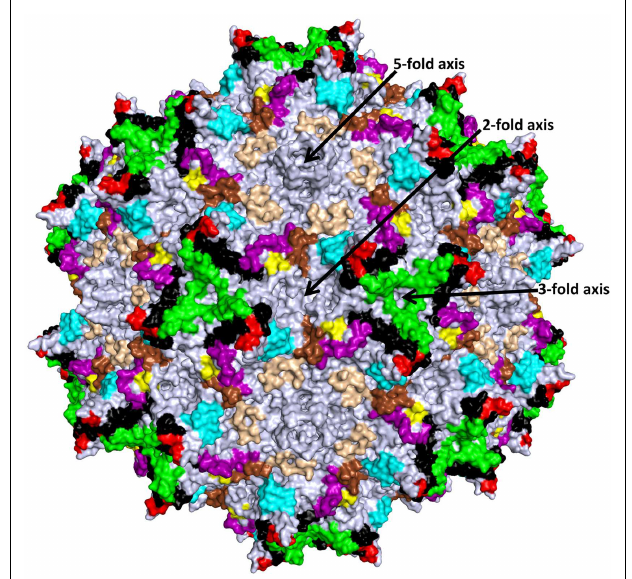
FIGURE 3 | Structurally mappedAAV antigenic epitopes .The epitopes identified on the AAV capsid surface by cryo-reconstruction structure are depicted in the colors used for theVRs in Figure 2 based on overlap with theVR amino acids; aa253–271: purple; aa383–386: yellow; aa456–459: red; aa492–515: black; aa544–557: cyan; aa582–597: green; aa659–669: wheat; and aa709–720: brown. Amino acids 659–669 (wheat) were not previously described asVR regions.The approximate icosahedral 2-, 3-, and 5-fold symmetry axes are indicated and labeled as in Figure 1 .This image was generated with the PyMOL program